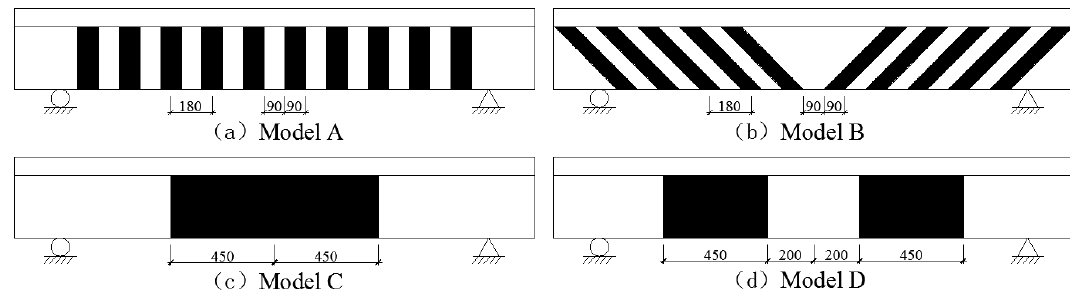
Figure 12. Four kinds of CFRP strengthening modes.